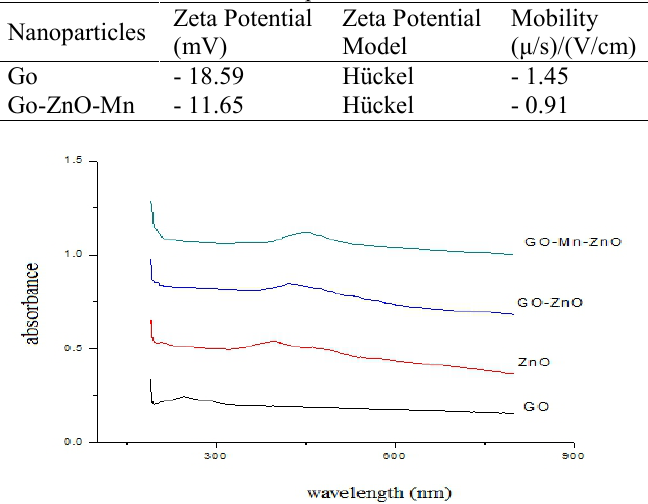
Fig. 8. UV-Vis Absorption Spectra of GO, ZnO, ZnO/grapheme, and GO-ZnO-Mn